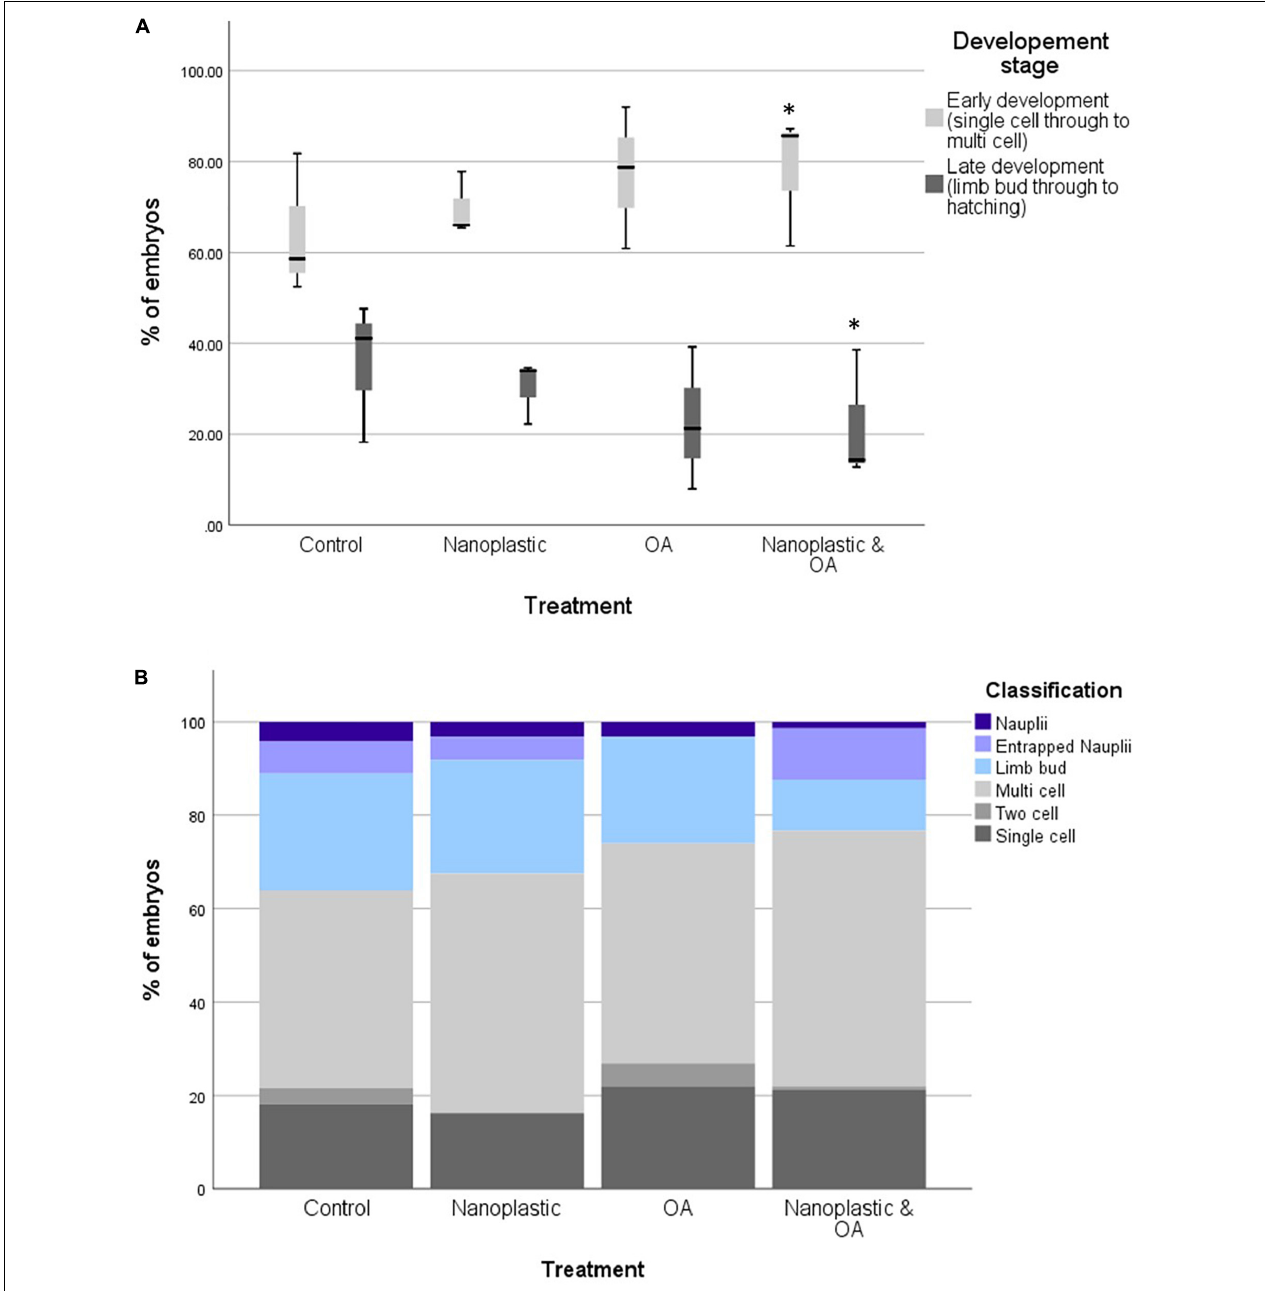
FIGURE 2 | (A) Percentages of krill embryos at the early (single cell to multi cell) and late (limb bud to hatching) developmental stage within each triplicate after 6 days of incubation in treatment conditions. Treatment conditions include control, nanoplastic (NP), ocean acidification (OA), nanoplastic and ocean acidification (NP and OA). Asterisk marks statistically significant difference from the control * < 0.05 with results from a binomial GLM. (B) The proportion of krill embryos at the early (single cell to multi cell) and late (limb bud to hatching) developmental stage after 6 days of incubation in treatment conditions. Treatment conditions include control, nanoplastic (NP), ocean acidification (OA), nanoplastic and ocean acidification (NP and OA). Total embryos analysed across the three replicates per treatment were 119 (control), 103 (NP), 107 (OA), and 129 (NP and OA).